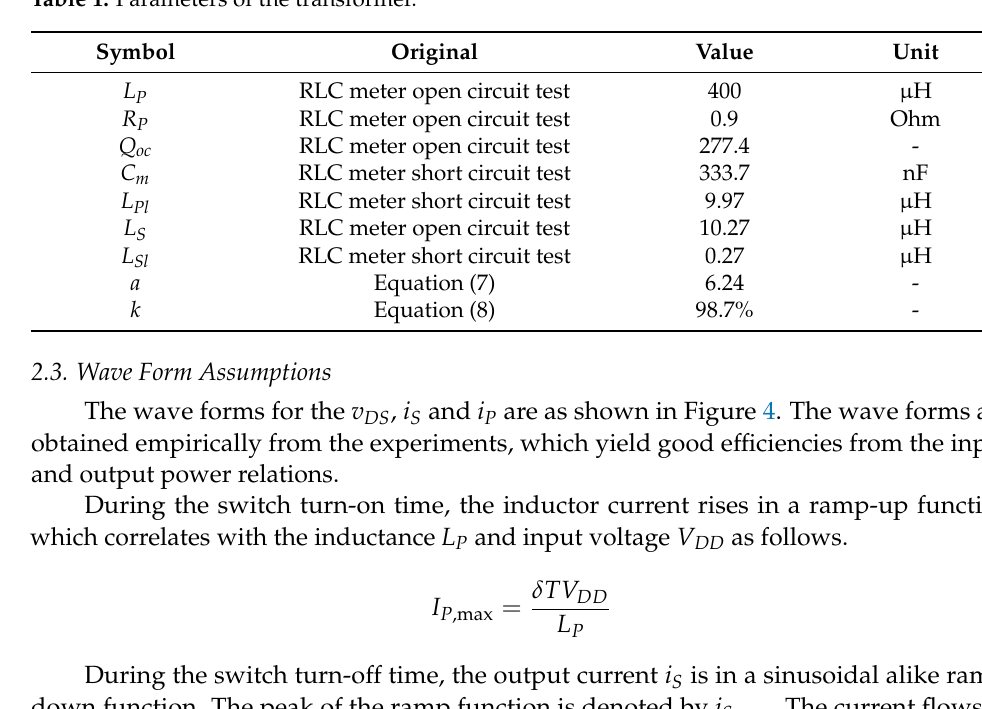
Table 1. Parameters of the